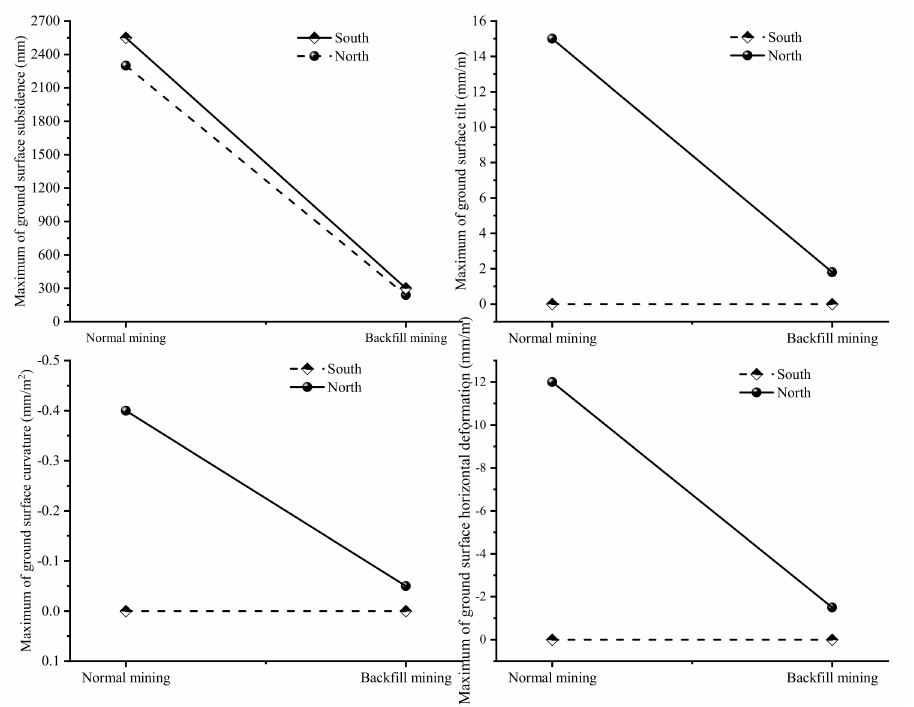
Figure 15. Final value of surface subsidence prediction for normal mining and backfill mining.